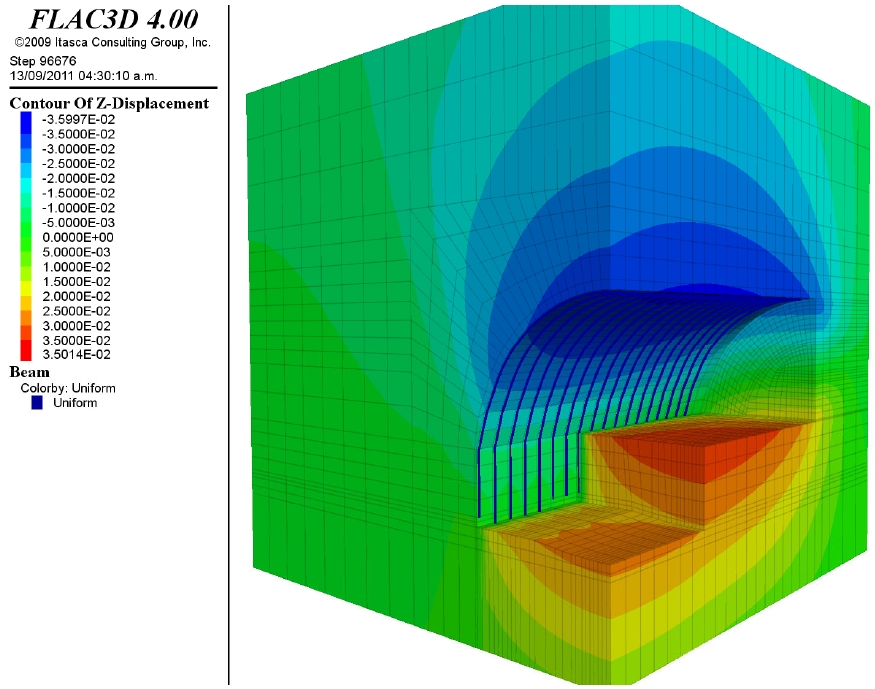
Figure 30. Vertical displacements (Uz in meters) in an intermediate stage of excavation. Minimum parameters.